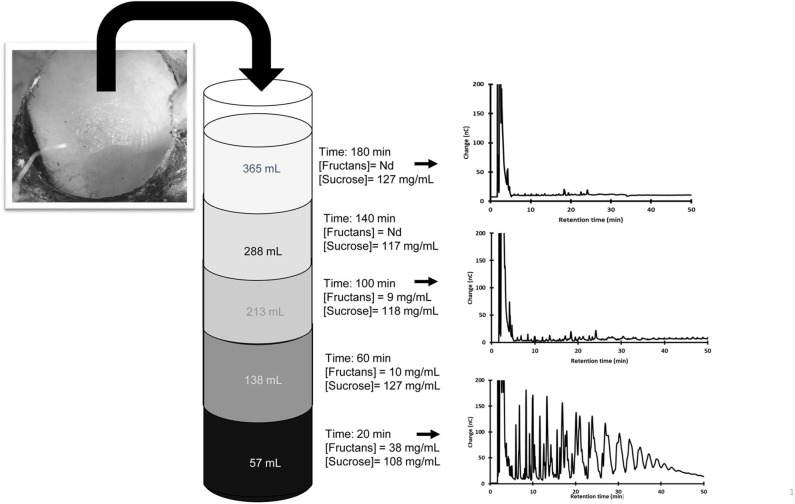
Changes in the concentration of sucrose, fructans, and the fructan profile in aguamiel exuded during the 3 h following scraping. Aguamiel samples were always collected in a previously emptied cajete to avoid dilution with accumulated aguamiel. Only three HPAEC profiles are shown.